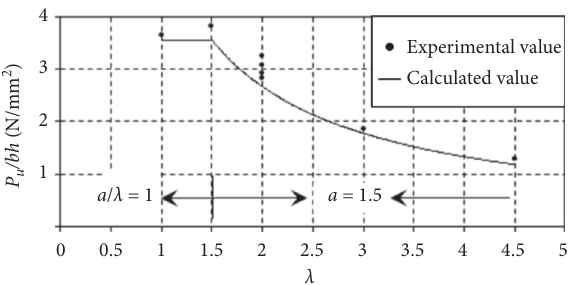
Figure 21: Fitting result of parameter a .